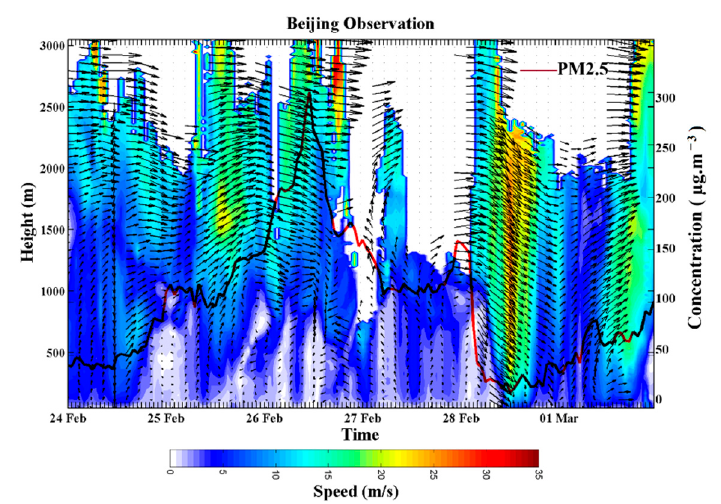
Figure 3. The simulated PM 2.5 concentrations (red line) and the PBL wind structures in Beijing, February 2018.